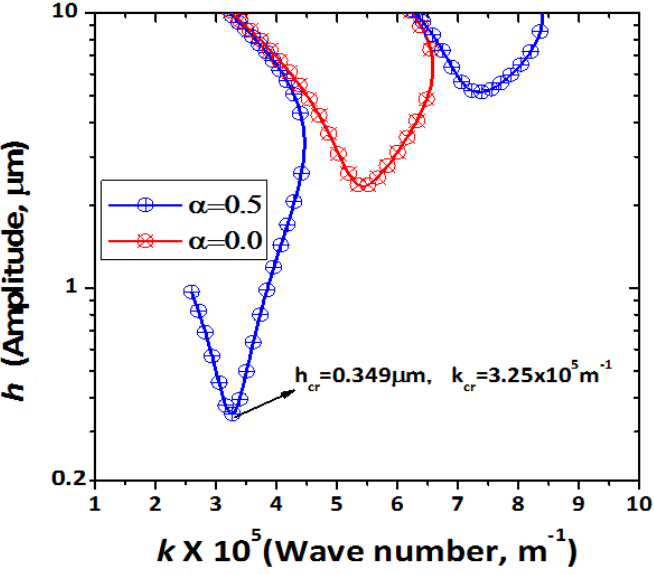
Figure 2. Relationship between the amplitude and the wave number at α = 0 and α = 0.5 for s = 0 at f = 500 kHz .